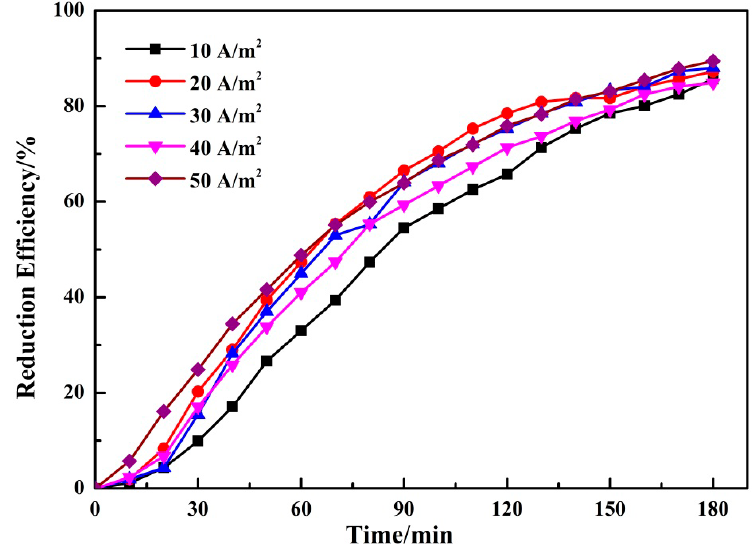
Figure 4. Effect of current intensity on reduction efficiency of chromium (VI).